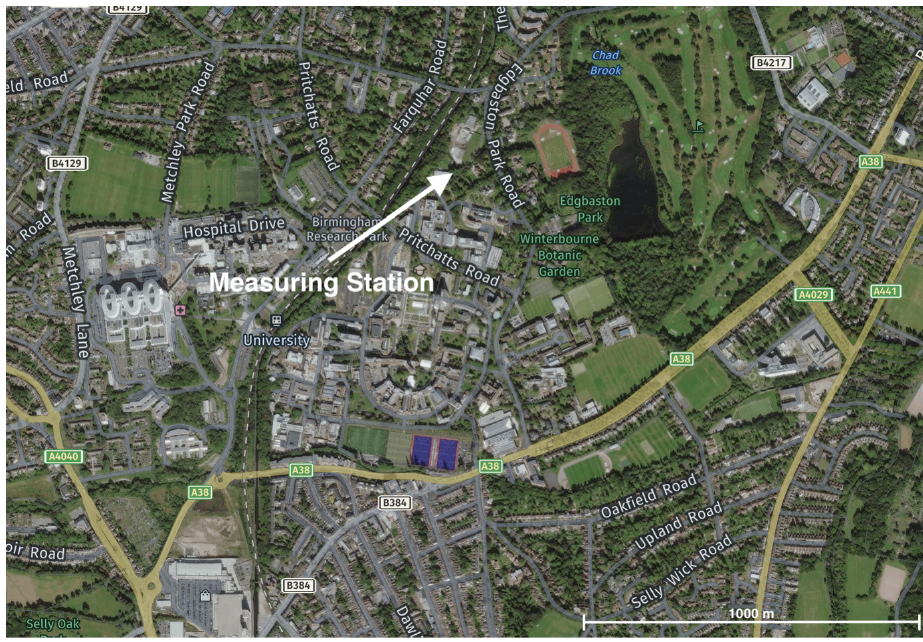
Figure 1. Map of the measuring station. Imagery @2022 Bluesky, Getmapping plc, Infoterra Ltd & Bluesky, Maxar Technologies, The GeoInformation Group, map data